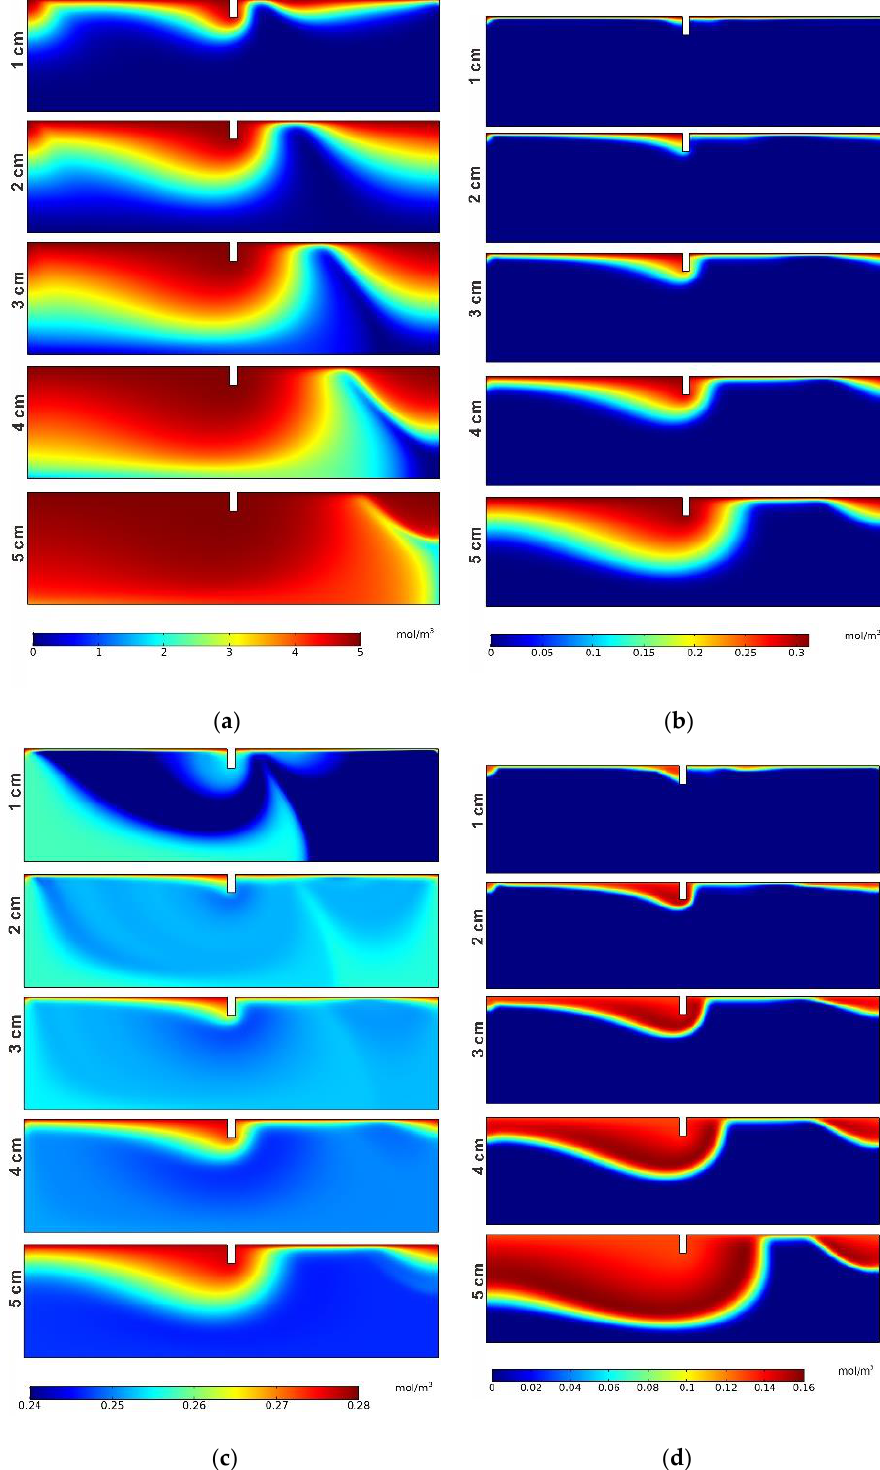
Figure 6. Concentration distributions of the four species in the five different height cases: ( a ) DOC; ( b ) DO; ( c ) NH 4+ ; ( d ) NO 3 − .